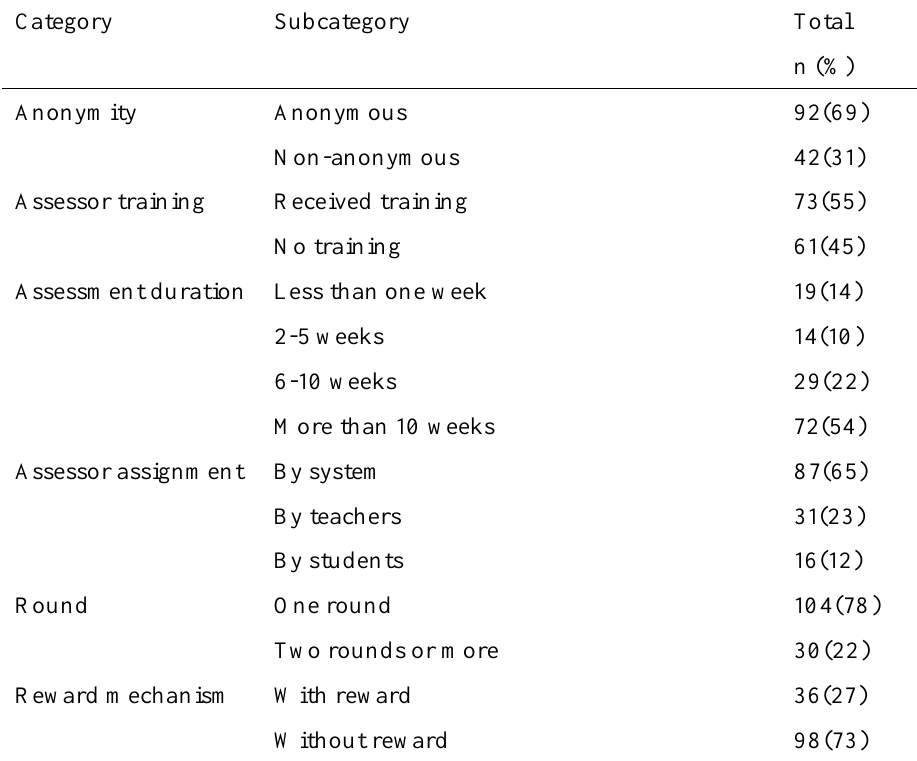
Descriptive Data for Peer Assessment